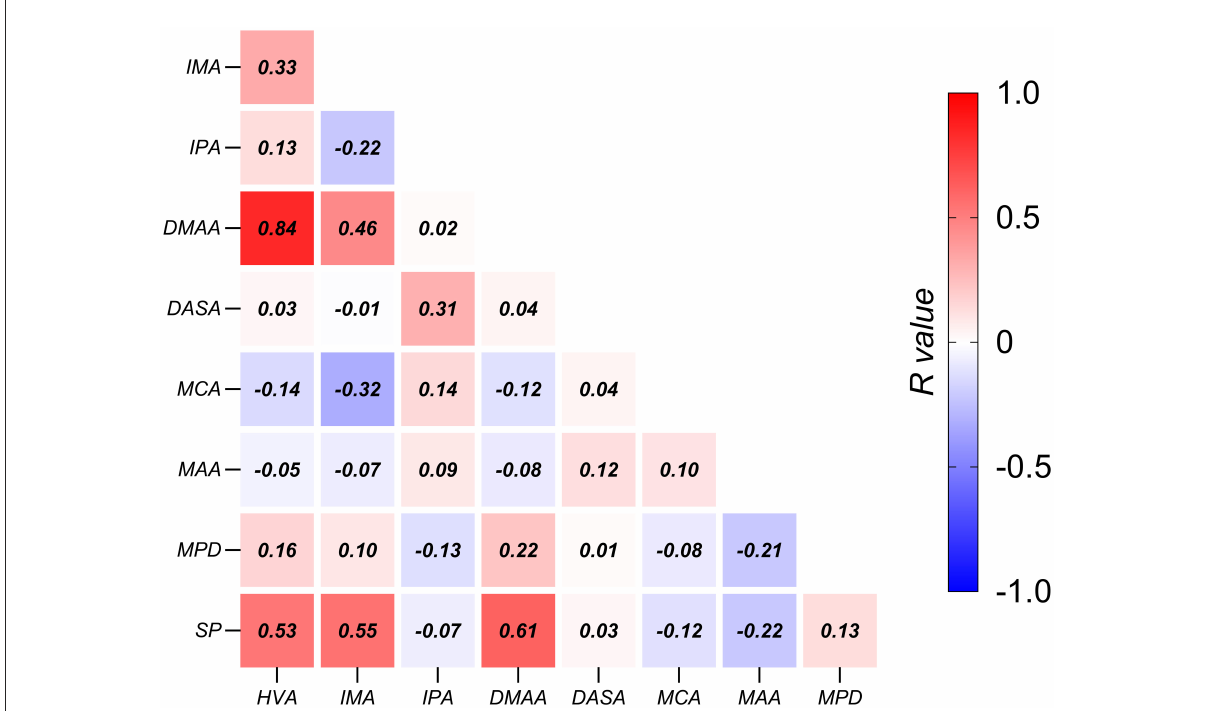
FIGURE2 Associations among radiographic metrics in HV. The correlation coefficients are shown in the center of each box. HVA, Hallux Valgus Angle; IMA, Inter-Metatarsal Angle; IPA, Inter-Phalangeal Angle; DMAA, Distal Metatarsal Articular Angle; DASA, Distal Articular Set Angle; MCA, Metatarsal Cuneiform Angle; MAA, Metatarsal Adducent Angle; MPD, Metatarsal Protrusion Distance; SP, Sesamoid Position.